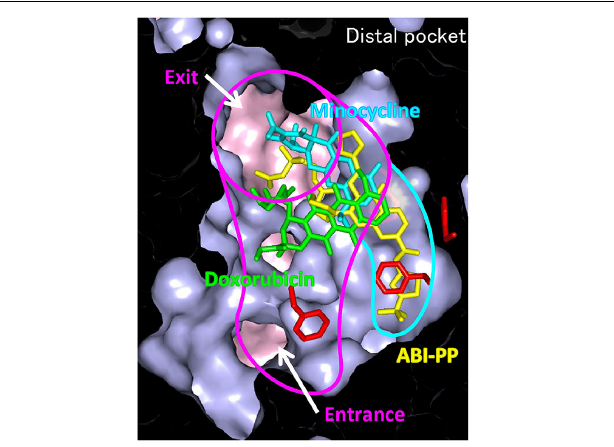
FIGURE 11 | Differences in the binding patterns of drug efflux pump to inhibitor, ABI-PP. Efflux pump inhibitor ABI-PP, penetrated and bound to a narrow hydrophobic domain that branches off from the substrate transport pathway, confirming the existence of an inhibitor-binding pit (Nakashima et al.,